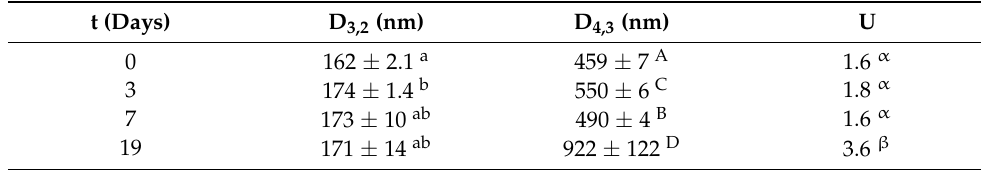
Table 4. Mean values of particle diameters and uniformity for an emulsion at 2.0 wt% of soy protein isolate, pH 2 and processed at 120 PSI. Different letters show significant differences ( p < 0.05).